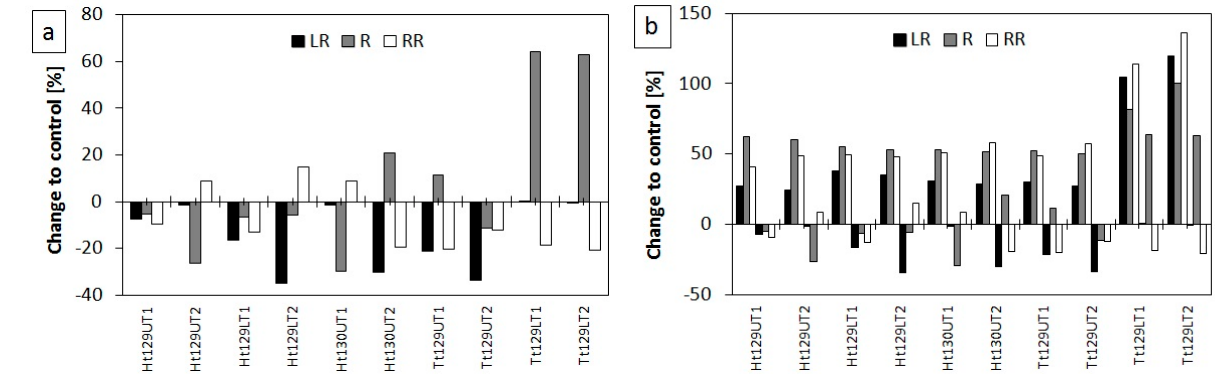
Figure 4. Changes in the values of ( a ) moisture content MC and ( b ) dry bulk density BD in relation to control.